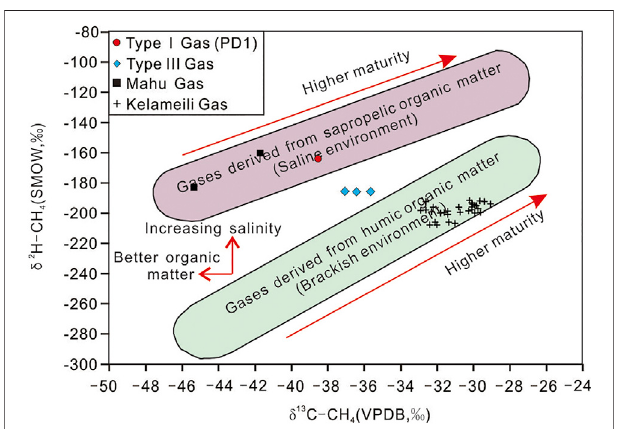
FIGURE6| The δ 13 C-CH 4 vs. δ 2 H-CH 4 plotofnaturalgasintheJunggar Basin (diagram modi fi ed after Wang et al., 2015).